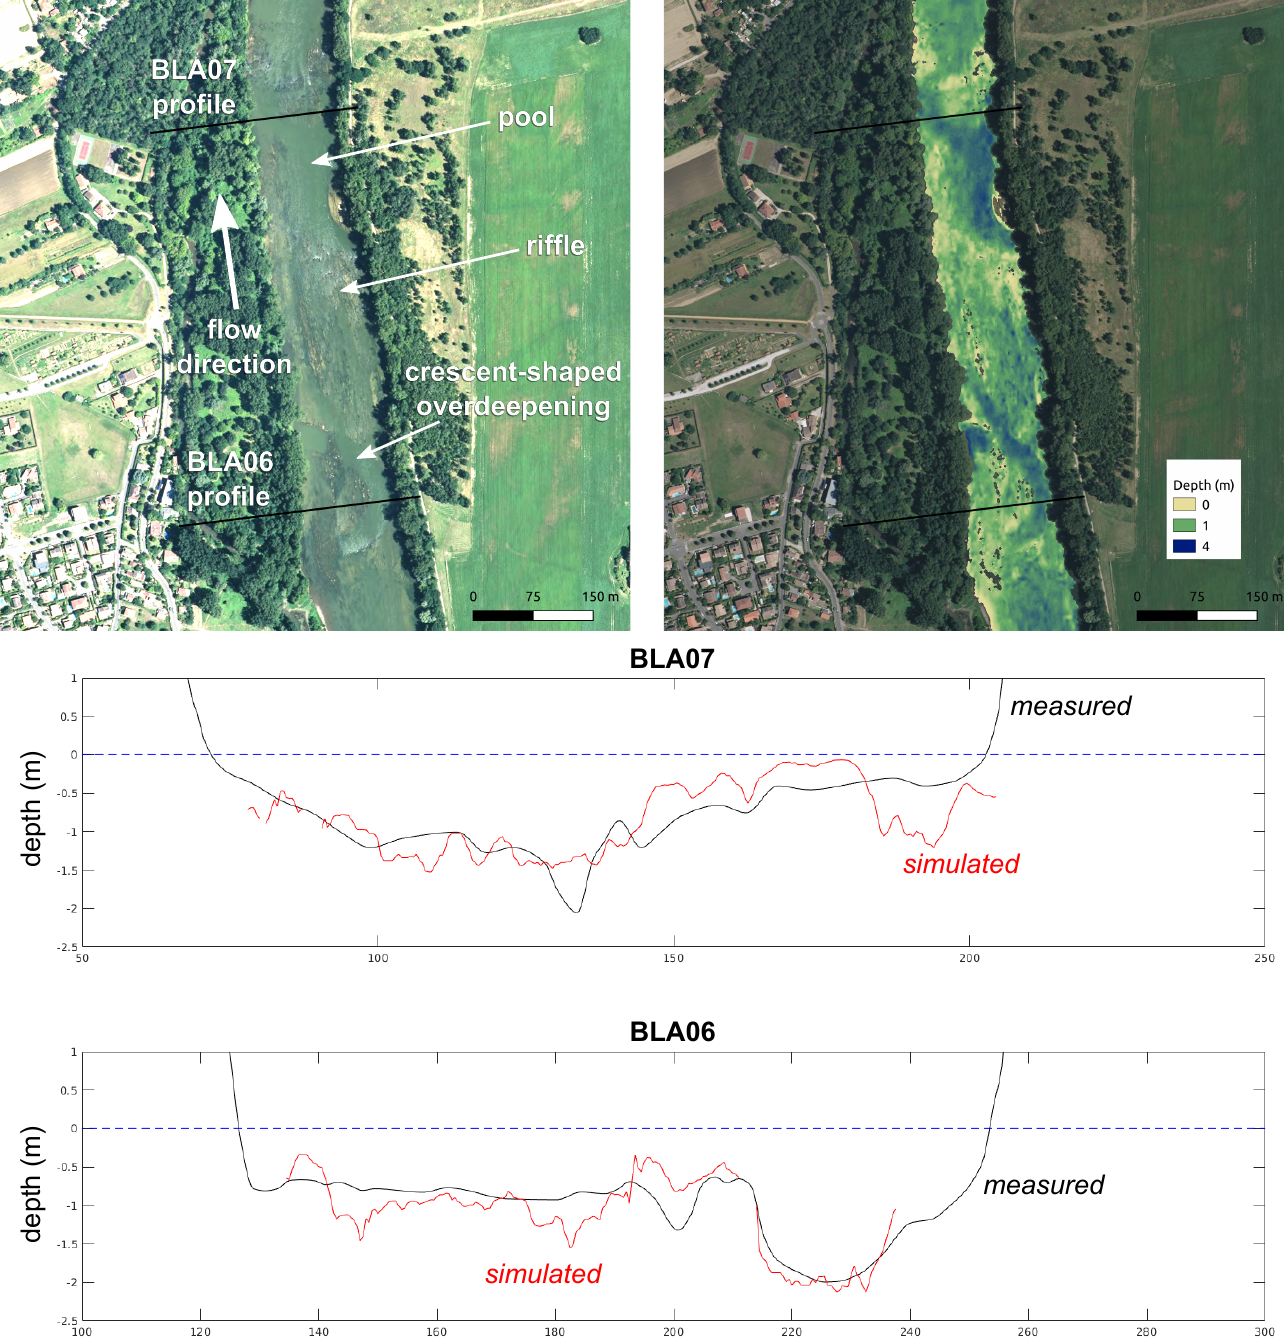
Figure 16. Comparison between measured and simulated depth along two surveyed cross-sections. The method is able to capture high-frequency variations in water depth: a typical example is the crescent-shaped feature visible at the bottom of the image, which is intersected by profile